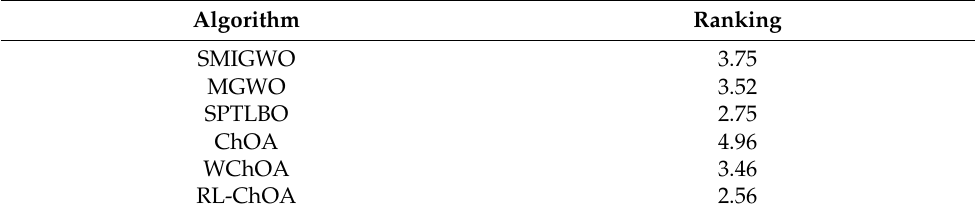
Table 7. Average rankings of the algorithms (Friedman) on multi-modal benchmark functions.